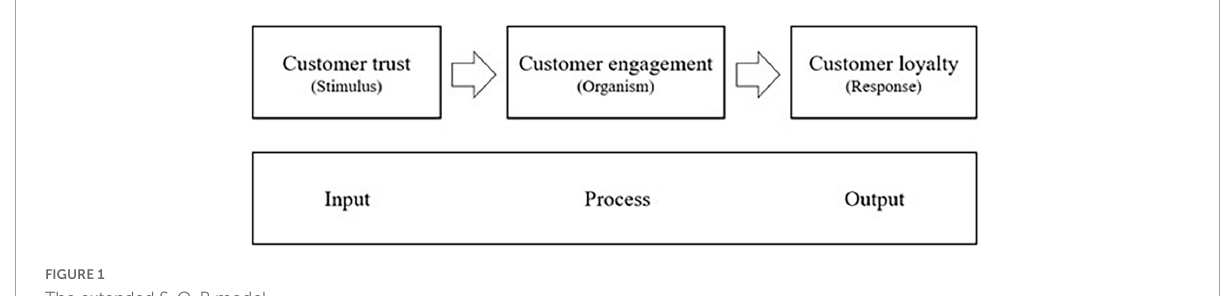
FIGURE1 The extended S-O-R model.